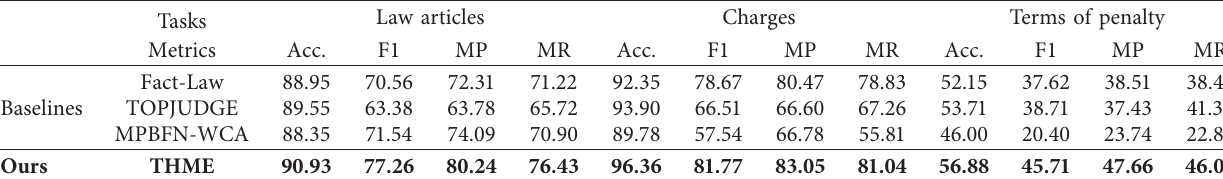
Table 6: Judgment prediction results on CJO.